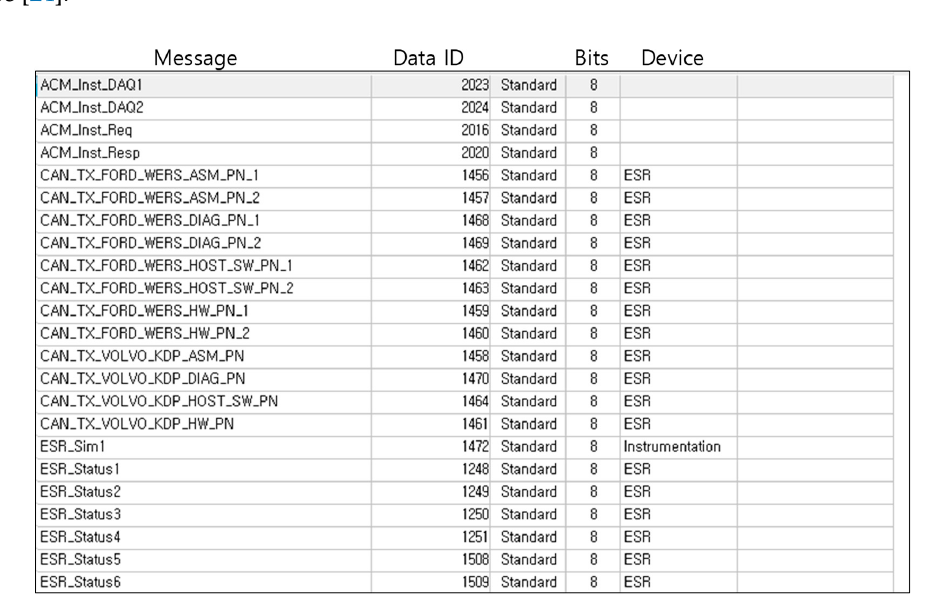
Figure 3. Example of excluded information in the Object Identification component.